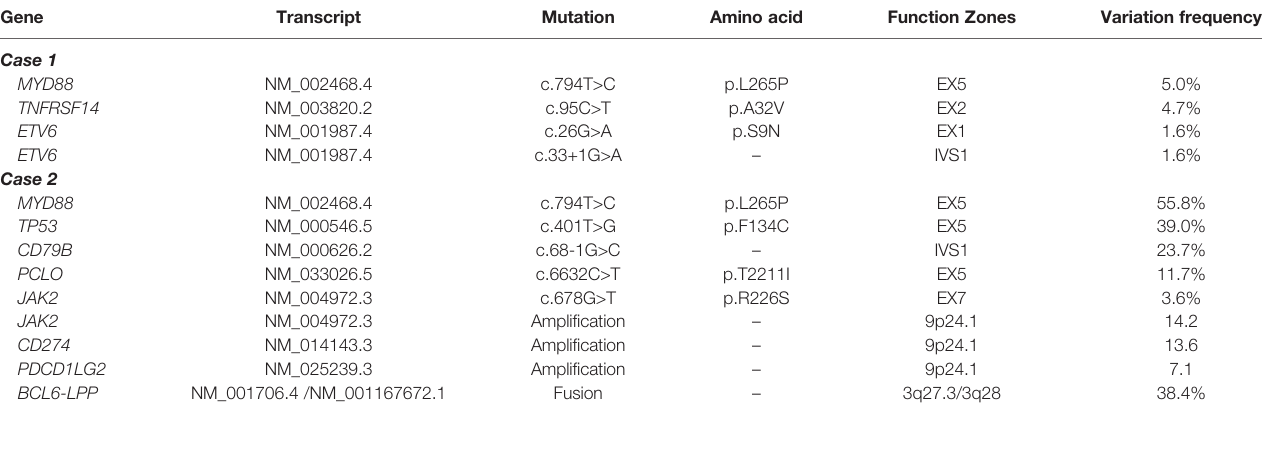
TABLE 1 | Gene mutations of cerebrospinal fl uid sample in two patients.